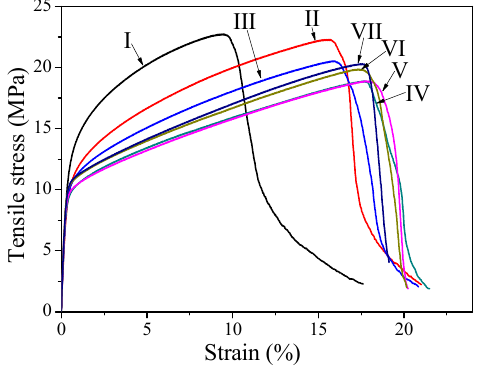
Figure 3. Tensile stress–strain curves for 316L SSFFs samples.